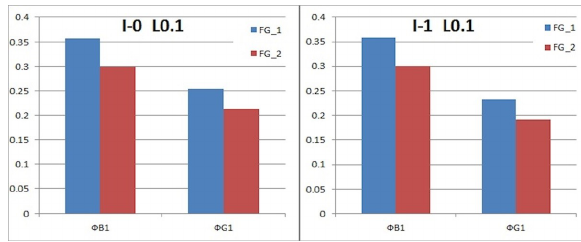
Figure 19: The safety factors of the bolt and gasket in case of joint load corresponding to tightness L0.1